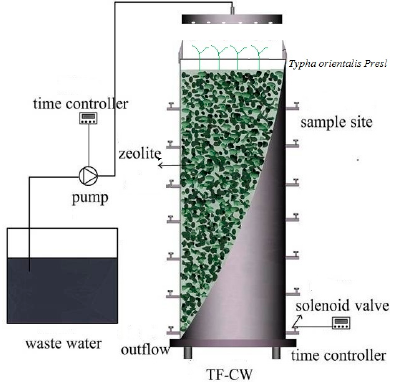
Figure 1. Experimental tidal flow constructed wetland (TF-CW) setup.